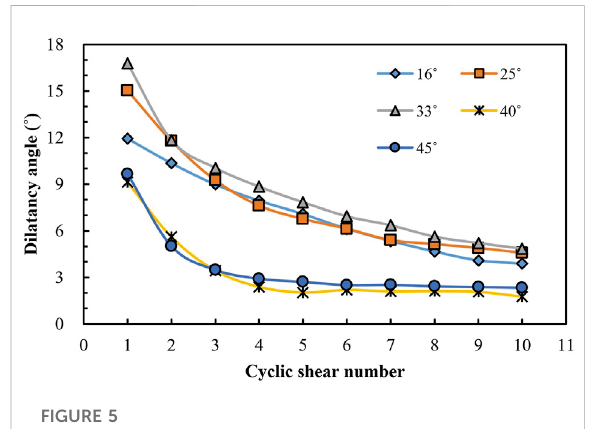
FIGURE 5 Variation of the average dilatancy angle with cyclic shear number with fi ve kinds of initial undulant angles (Liu et al.,